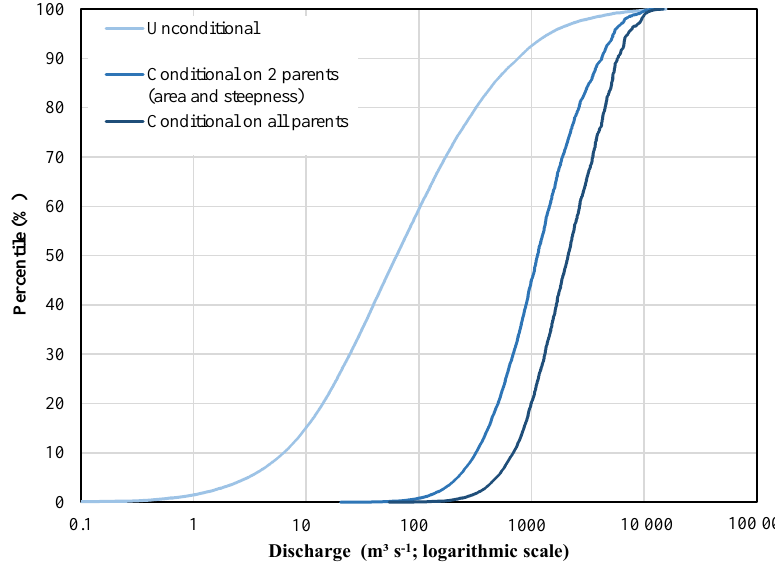
Figure 4. Cumulative probability distribution of river discharge: unconditional and conditionalized on two and seven nodes using values for Basel station in Switzerland (river Rhine, year